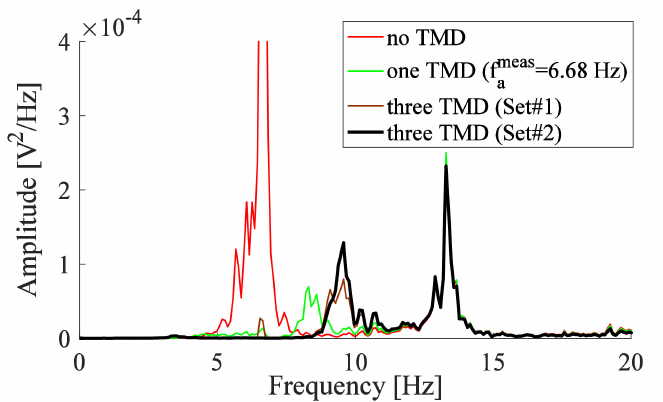
Figure 10. PSD obtained from vibrometer measurements for the system with one TMD adjusted to the optimal frequency compared with that obtained with three